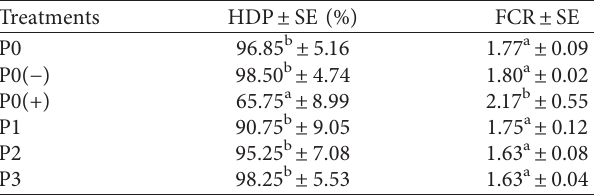
Table 1: Average HDP and FCR in laying chickens infected with APEC and given a combination of acidifier-dextrose through drinking